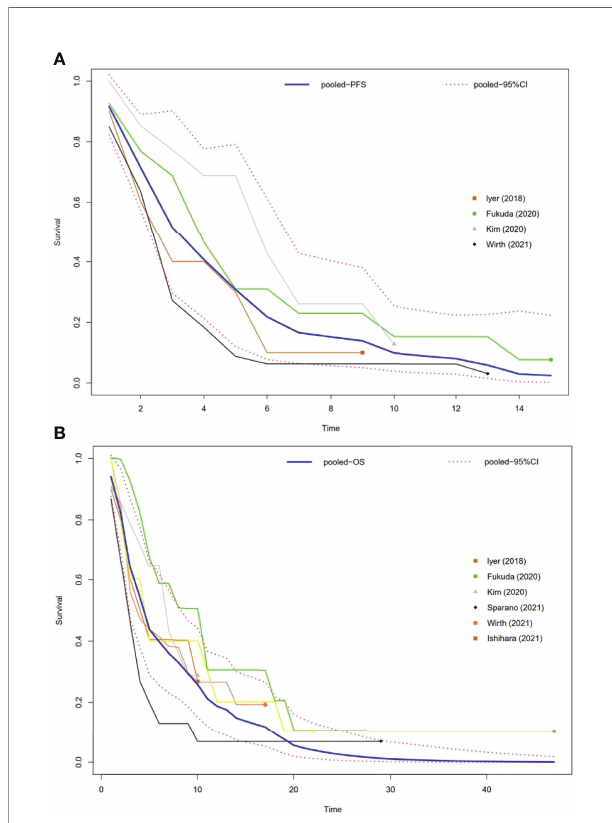
FIGURE 3 | Pooled Kaplan – Meier survival curves of ATC patients. (A) Pooled Kaplan – Meier PFS curves of ATC patients. (B) Pooled Kaplan – Meier OS curves of ATC patients.